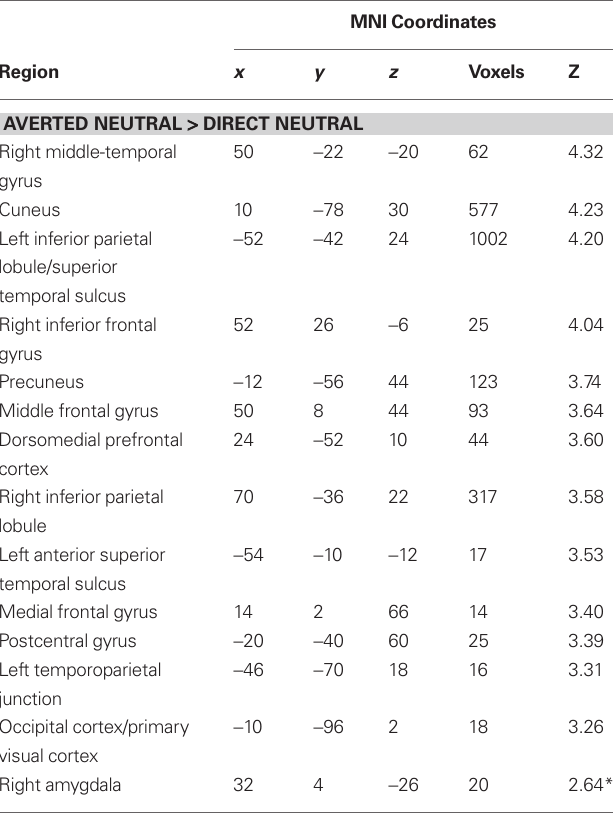
Table 4 | Regions in which activation to neutral faces showed a significant positive relationship with state anxiety scores. All activations are significant at P < 0.001 whole brain